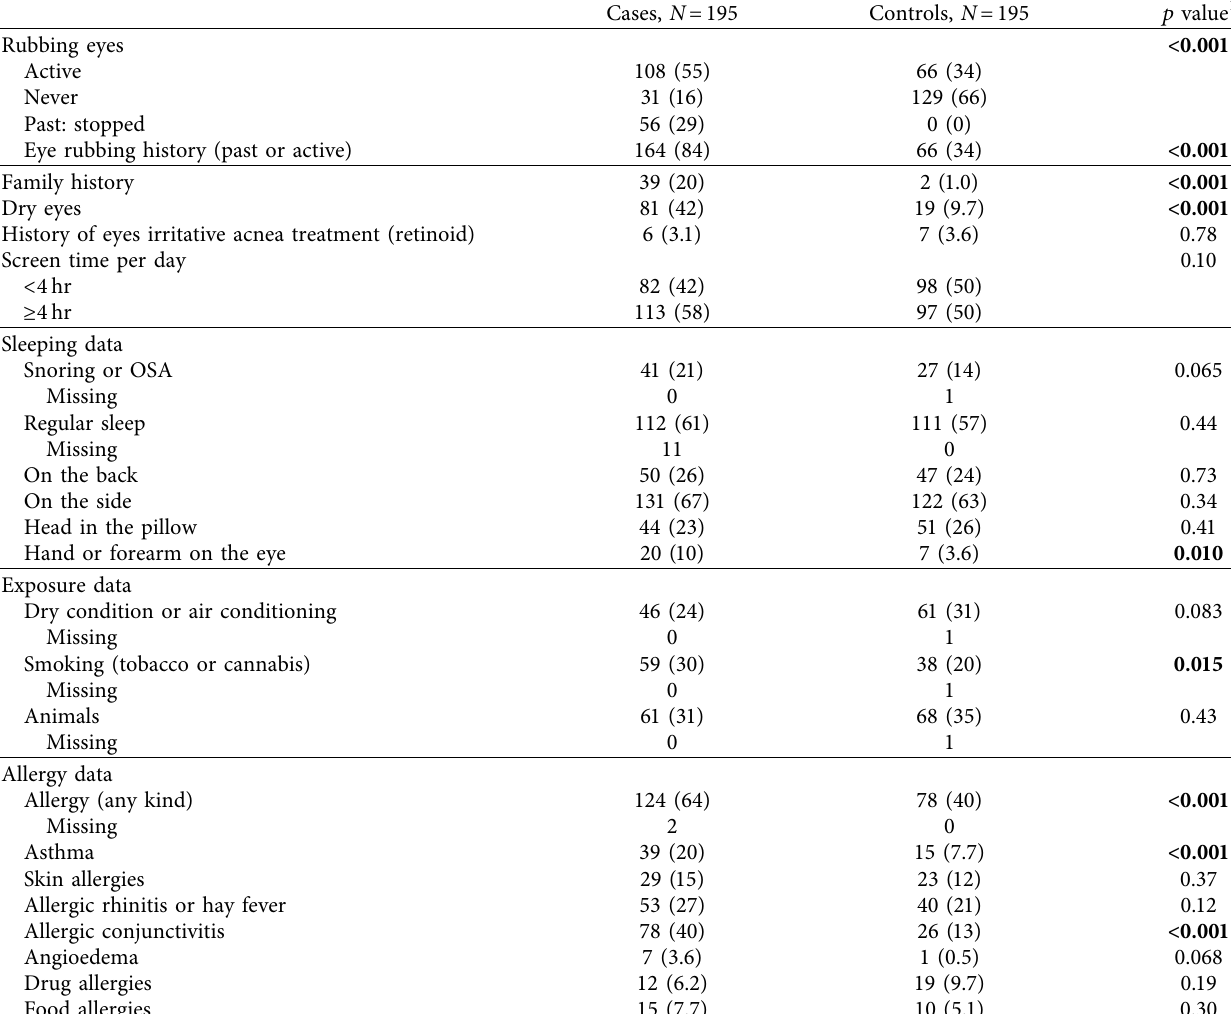
Table 2: Risk factors of keratoconus and univariate